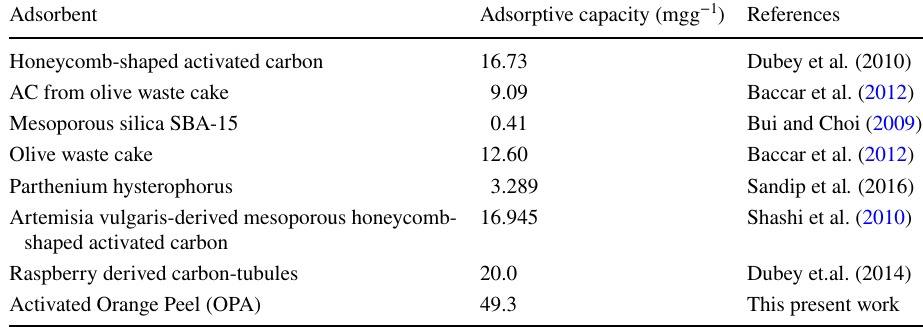
Table 4 Adsorption capacities of IBP on various